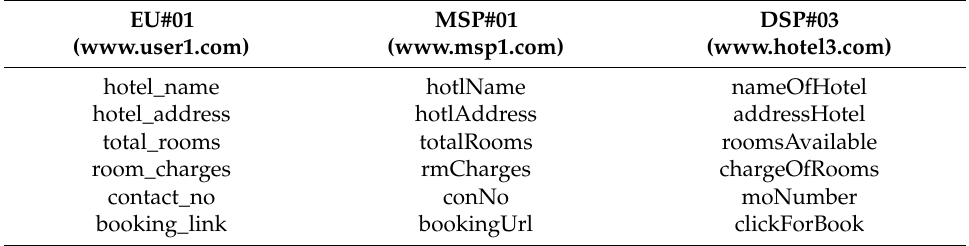
Table 8. End to End SDXMapping between EU#01 and (MSP#01 and DSP#03).